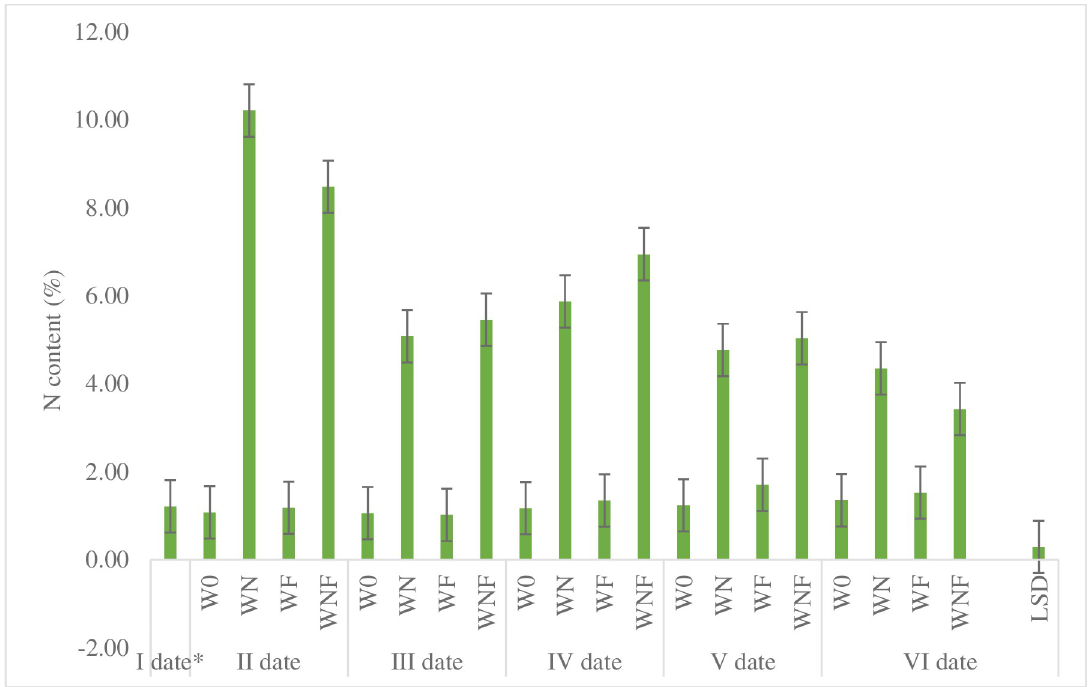
Fig 3. The effect of composting processes on total N content (%) for different terms of sampling and variants of composting. � before composting, LSD Least Significant Difference.